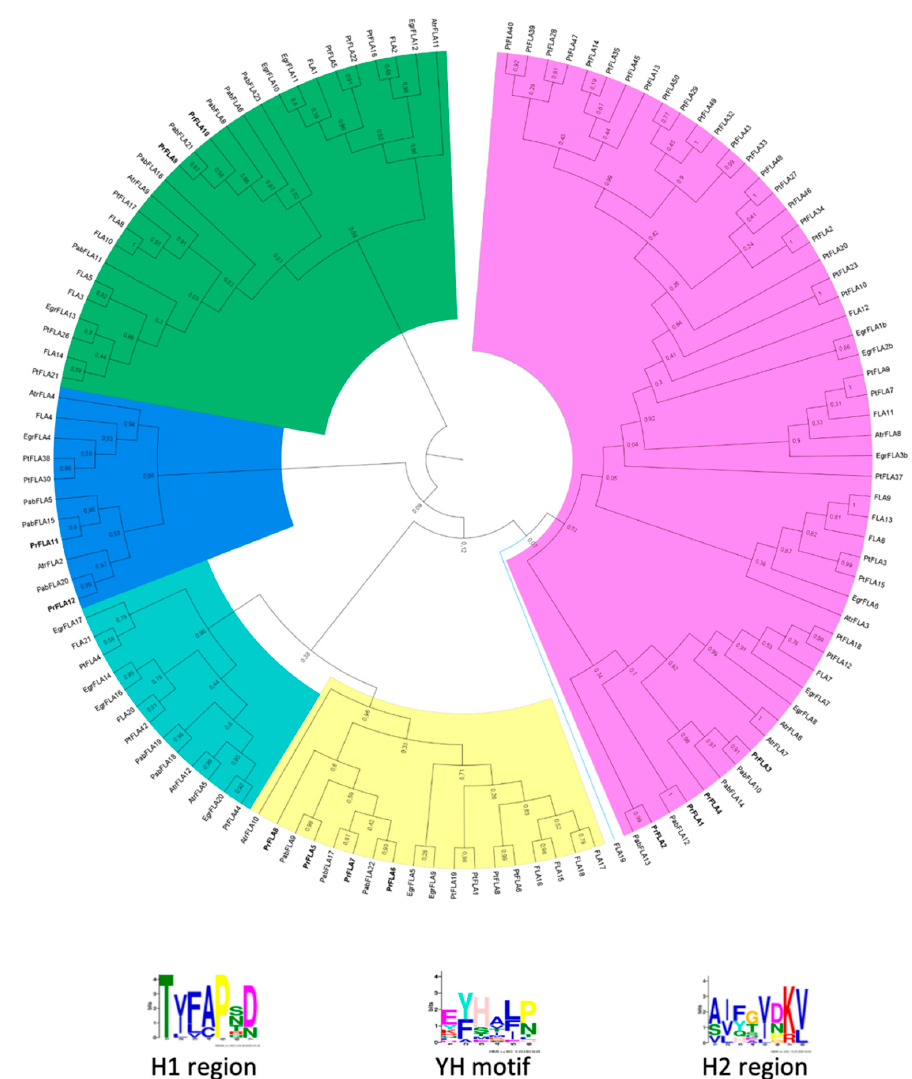
Figure 1. Phylogenetic comparison of pine protein sequences with Arabidopsis, Amborella, Euca- lyptus, Populus and Picea. Amino acid sequences of fasciclin were aligned by ClustalX, and the phylogenetic tree was built by MEGA X using Maximum Likelihood (ML) and JTT matrix-based model with 5000 N° of Bootstrap replications. The tree was divided into five major clades: Group A (pink), Group B (yellow), Group C (green), Group D1 and Group D2. The conserved motifs (H1, H2, and YH motifs) in pine’s sequences shown below the tree were found using the MEME web server.